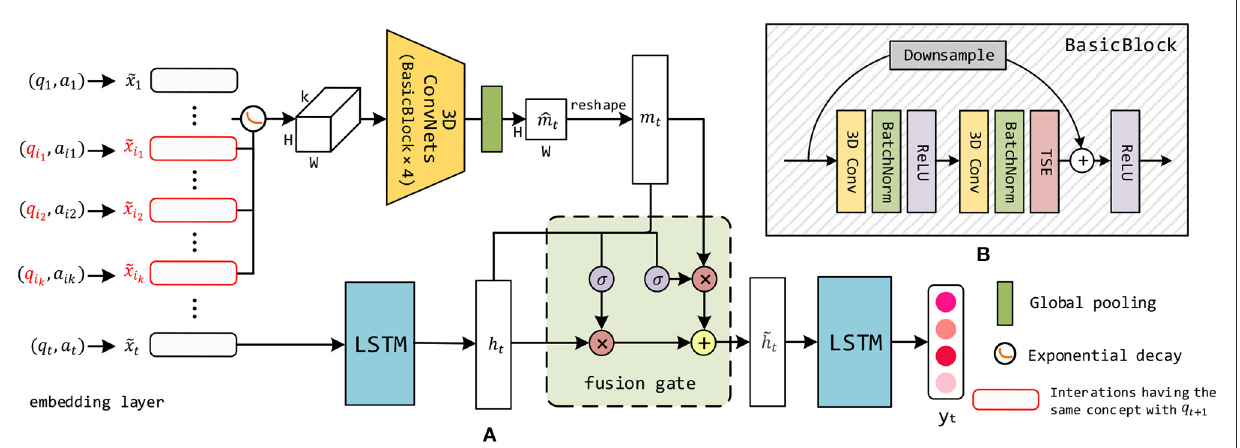
FIGURE2 (A) The overall architecture of CAKT. The red rounded rectangles represent the embeddings of the interactions that apply the same knowledge concept with that of q t + 1 . The 3D-ConvNets and the left LSTM layer extract the features m t pertaining to the latent knowledge state on the concept covered by q t + 1 and the overall latent knowledge state h t , respectively. The component to the left of the tensor represents the exponential decay function. The 3D-ConvNets module consists of four BasicBlocks depicted in (B) . The fusion gate adaptively integrates the two features. Finally, the right LSTM layer transforms the fused feature and outputs the integrated knowledge state y t . (B) Each BasicBlock consists of two 3D convolutional layers, two batch normalization layers, two ReLU layers and one TSE layer. It also employs a residual connection between the input to the block and the output of the TSE